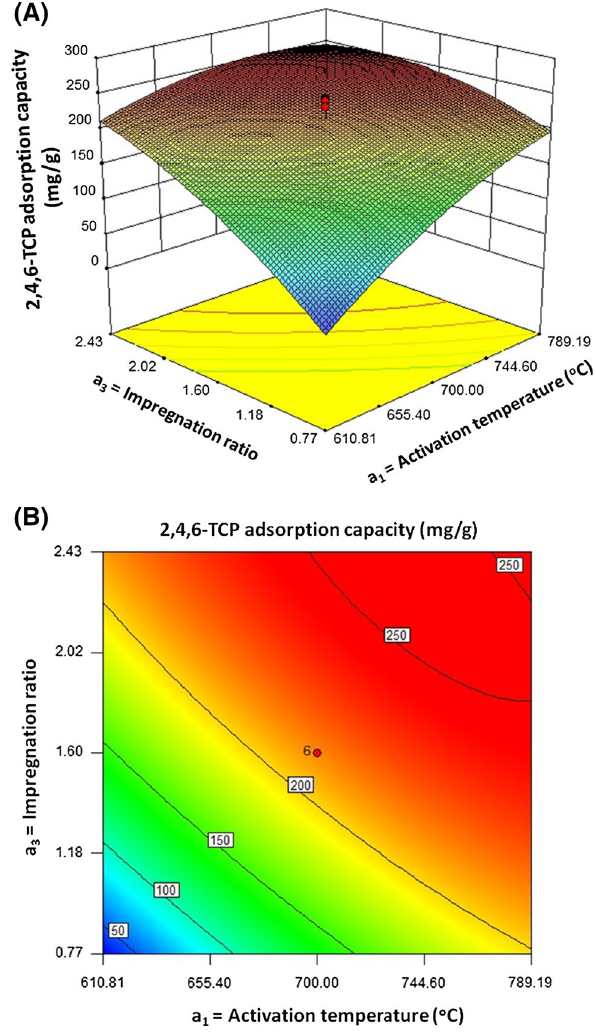
Fig. 4 Response surface plots of 2,4,6-TCP adsorption capacity by CSSS-AC; a 3D response surface plots demonstrating the effect of activation temperature and IR (activation time = 135 min) and b con- tour plots effect of the same variables on the 2,4,6-TCP adsorption capacity by CSSS-AC (Y 2,4,6-TCP